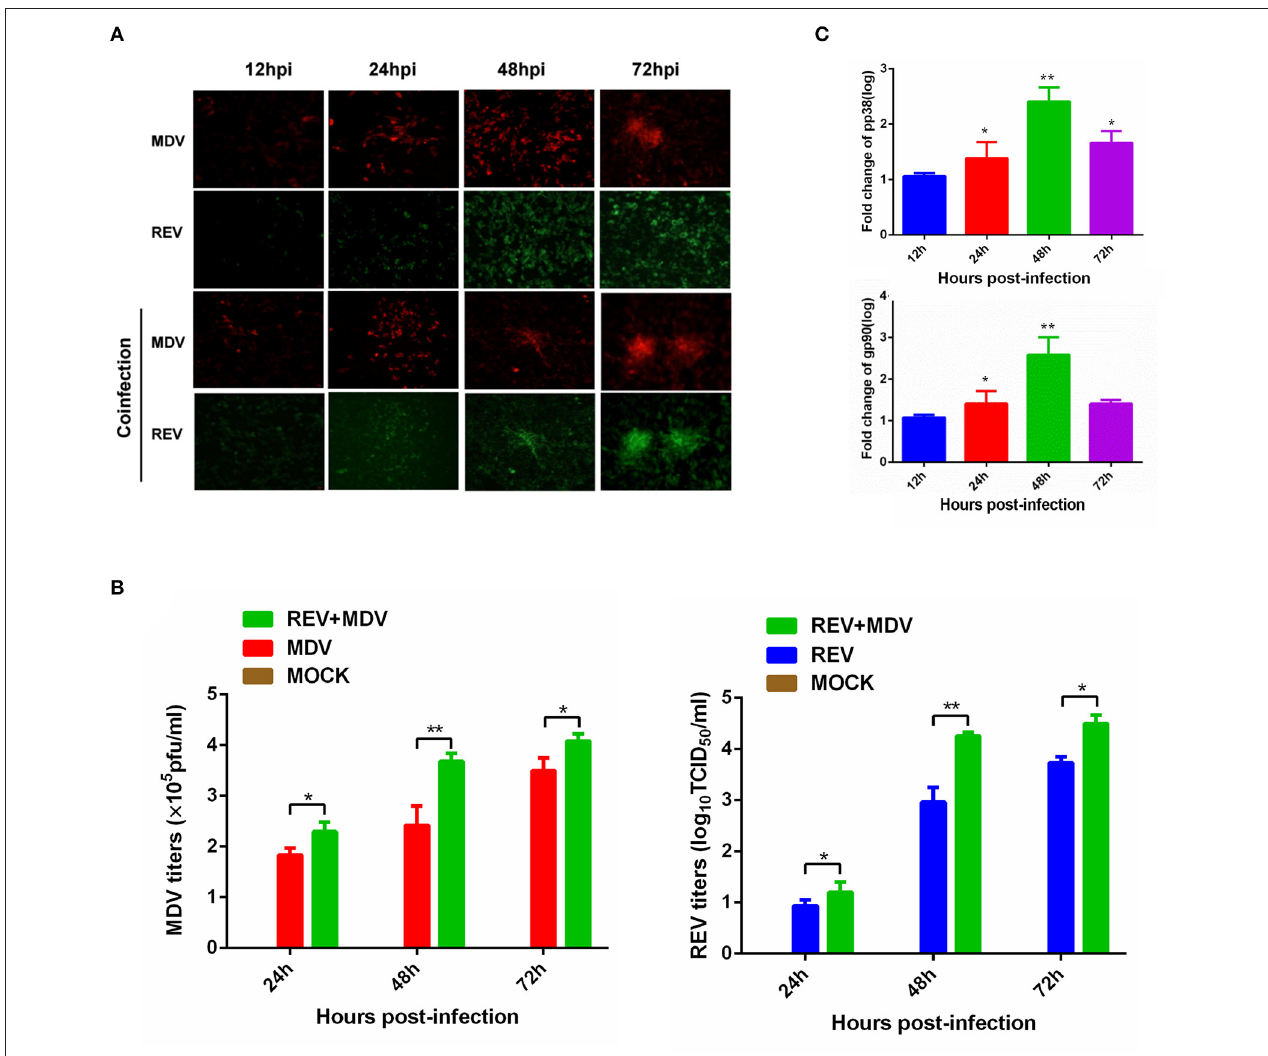
FIGURE 1 | Synergistic infection of MDV and REV increases the two viruses’ replication in CEF. (A) Detection of MDV-pp38 and REV-gp90 in infected CEFs was visualized by IFA from 24 to 72 hpi. FITC-labeled goat anti-mouse IgG (for REV) (green) and Cy3-labeled goat anti-rabbit IgG (for MDV) (red) were used as the secondary antibodies in the assay. (B) The MDV and REV viral titers were tested from 24 to 72 hpi. (C) Differential expression fold change of MDV pp38 and REV gp90 genes in the MDV and REV coinfected cells compared to the single-infected control group. The fold change between both groups is shown using a logarithmic scale. Data are presented as the mean ± SD from three independent experiments. * p < 0.05; ** p < 0.01. MDV, Marek’s disease virus; REV, reticuloendotheliosis virus; CEF, chicken embryo fibroblast; IFA, immunofluorescence assay; FITC, fluorescein